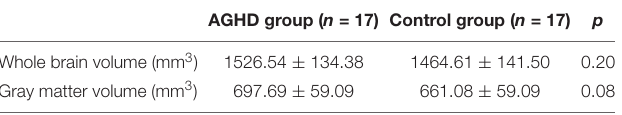
TABLE 2 | Comparison of whole brain volume and gray matter between study groups.